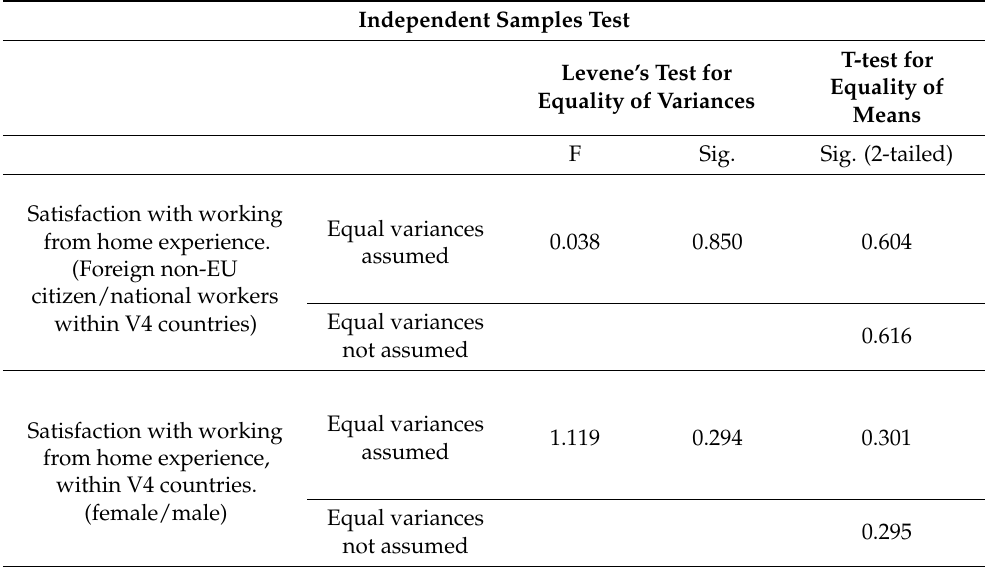
Independent Samples Test T-test for Levene’s Test for Equality of Equality of Variances Means F Sig. Sig. (2-tailed)